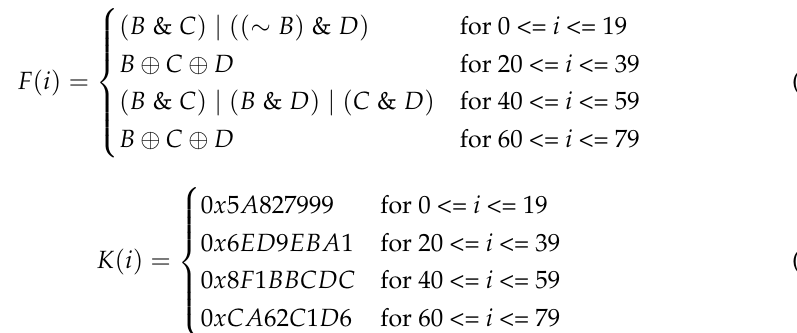
After 80 rounds for the given block, the H registers are updated as in Listing 2. When all blocks of the message are processed, the hash can be read as a concatenation of H